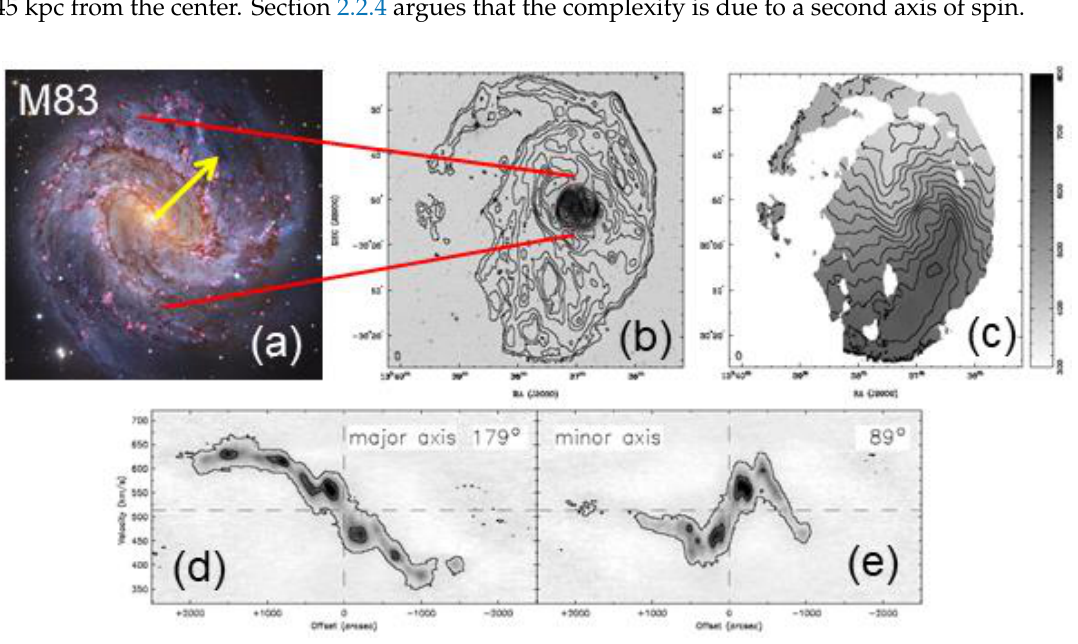
Figure 4. Pictorial essay of an RC extraction for a giant spiral galaxy with an unusually large baryonic atmosphere and a twisted velocity field: ( a ) Detailed, visual image of M83, which is type SAB(s)c with a double nucleus, by William Blair, NASA, ESA, and the Hubble Heritage Team (STScI/AURA), publicly available at http://www.spacetelescope.org/images/heic1403a/. Red lines link this image with the area mapped in Doppler measurements. Yellow arrow marks one possible 2nd axis of spin, from symmetry of the arms; ( b ) Integrated HI distribution overlaid onto the B-band image of M83; ( c ) The mean velocity field, plotted on the same scale; ( d ) Position-velocity diagram along the major axis with the inclinations stated; ( e ) The minor axis. Panels ( b ) to ( e ) are a high-resolution study of the 21 cm band which used the Australia Telescope Compact Array and are modified after supplement figure A50 in “The Local Volume HI Survey (LVHIS)” by B.S. Koribalski et al. (2018) Mon. Not. R. Astron. Soc. 478 , 1611–1648 [56].